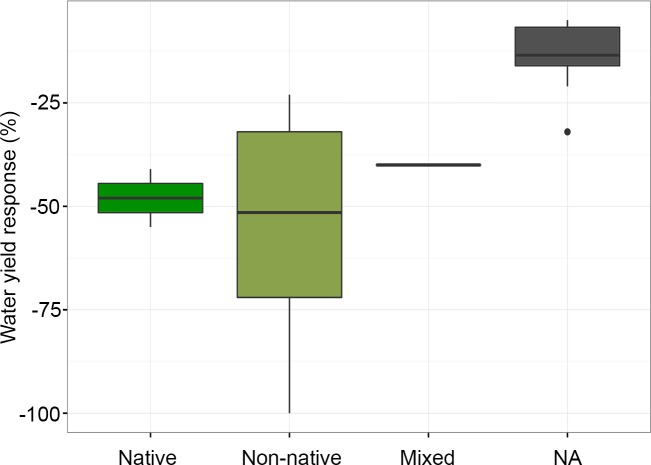
Magnitude of water yield change by forest type.Box plot showing the median, quartiles, maximum and minimum, and outlier values for changes in water yield following forest restoration or cover expansion. These results are based on a subset of case studies selected for meta-analysis (n = 37). NA refers to the category of studies with no information on tree species or forest types.